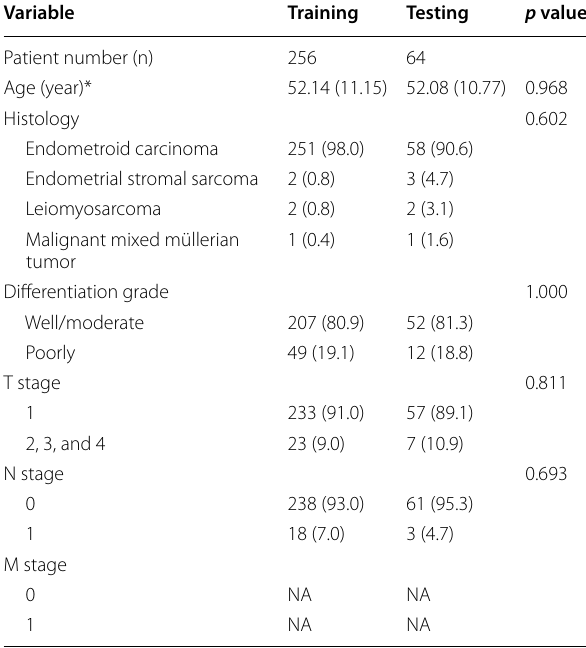
Table 1 Patient demographics of the uterine dataset